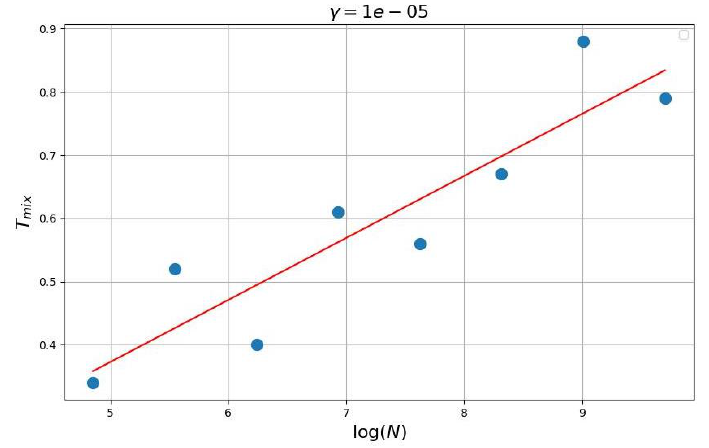
Figure 4. Best response dynamic (as a limit of logit-choice dynamics γ → 0 +